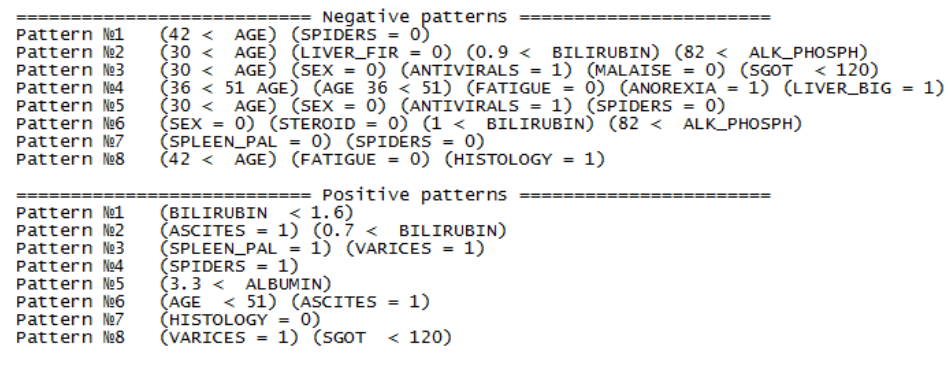
Figure 2. Examples of patterns for problem 2.